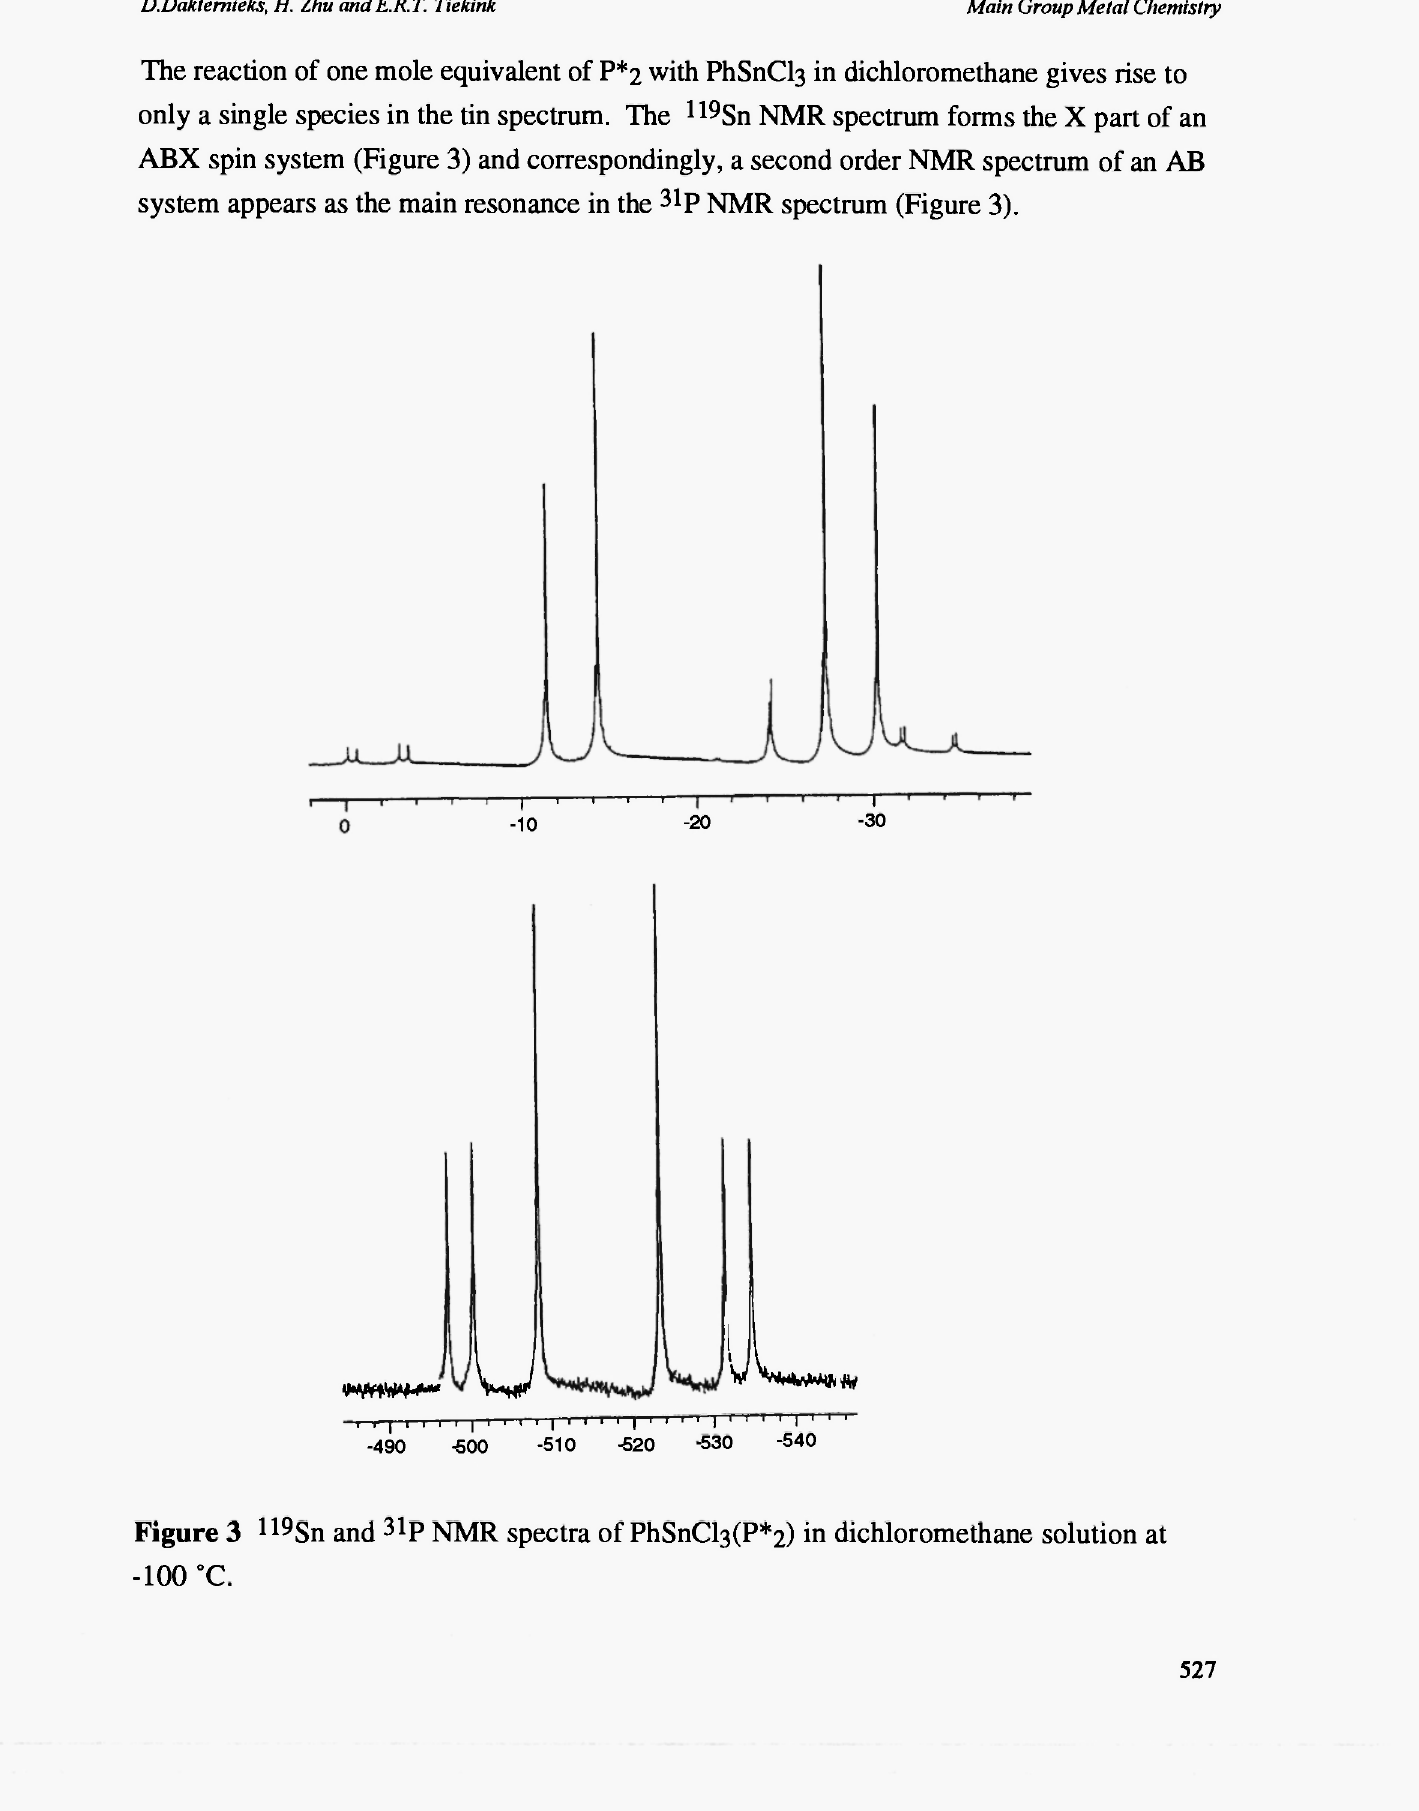
Figure 3 119 Sn and 31 P NMR spectra of PhSnCl3(P*2) in dichloromethane solution at -100